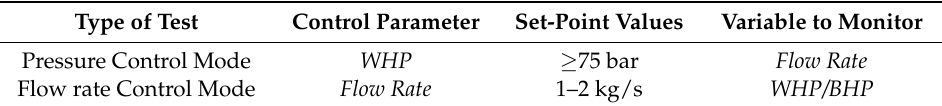
Table 1. The main characteristics of the injection